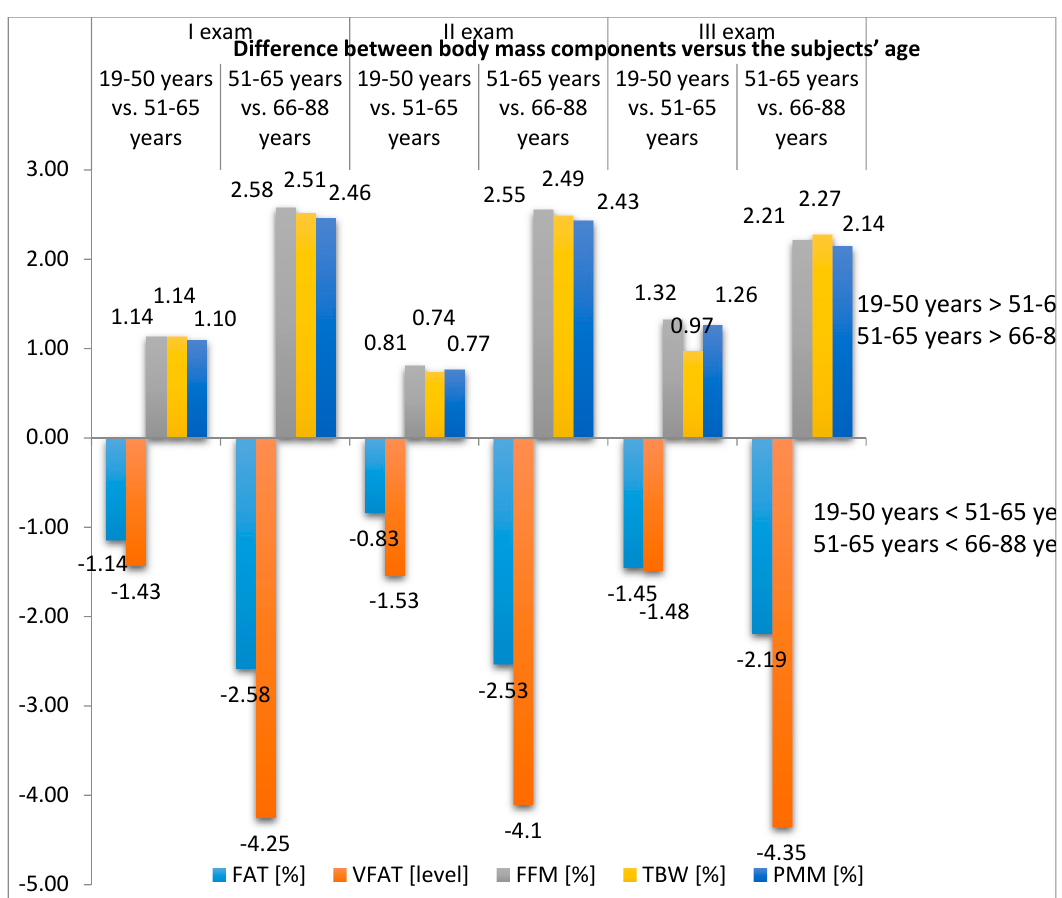
Figure 2. Difference between body mass components versus subjects’ age. Figure 2. Di ff erence between body mass components versus subjects’ age. Table 3. Body mass components versus type of stroke.